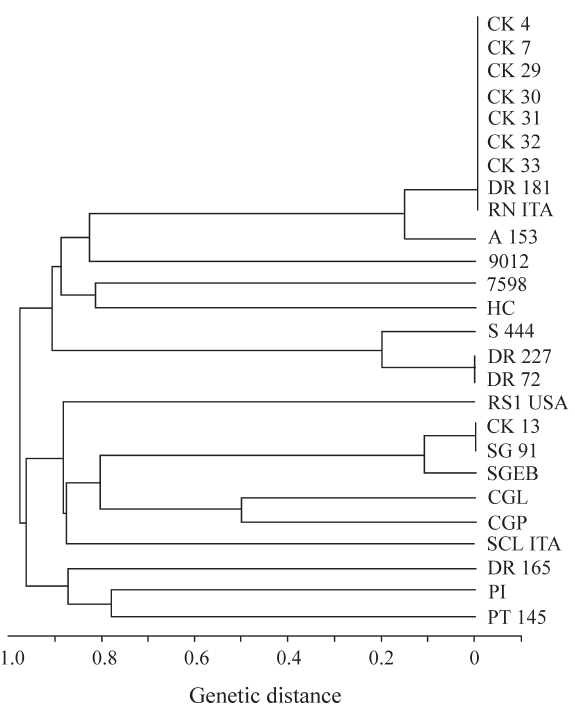
Figure 3 - Unweighted pair group method with averages (UPGMA) clus- ter diagram of the relationships between 26 ectomycorrhizal fungi iso- lates. The dendrogram was based on genetic similarity coefficients determined by the presence and absence of rDNA internal transcribed se- quence (ITS) region restriction enzyme patterns.